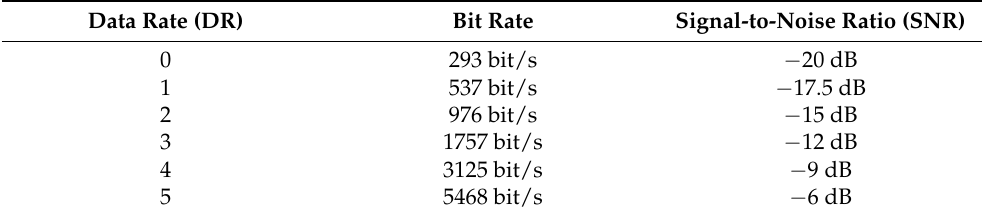
Table 2. Evolution of the bit rate and acceptable sensitivity depending on the data rate. BW = 125 kHz and CR = 4/5.